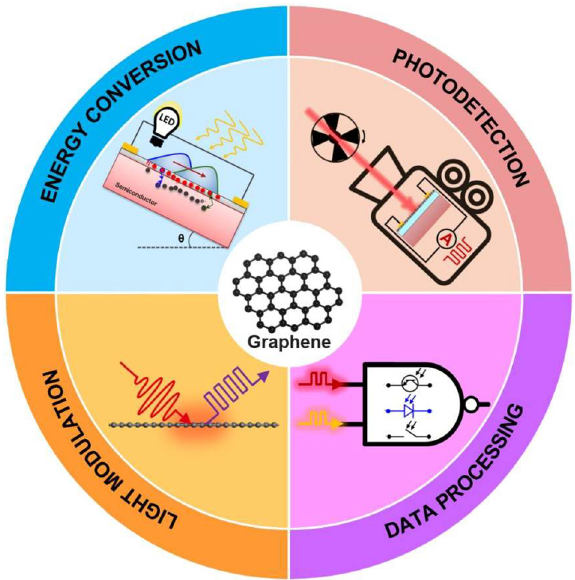
Figure 6: Schematic representation of the application domains for all-optical modulation of